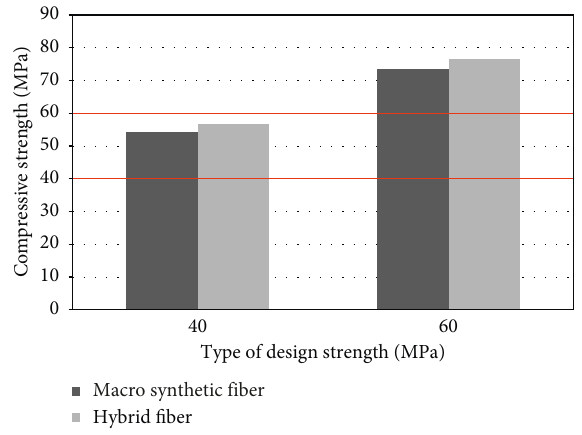
Figure 5: Compressive strength of the optimum mixture.